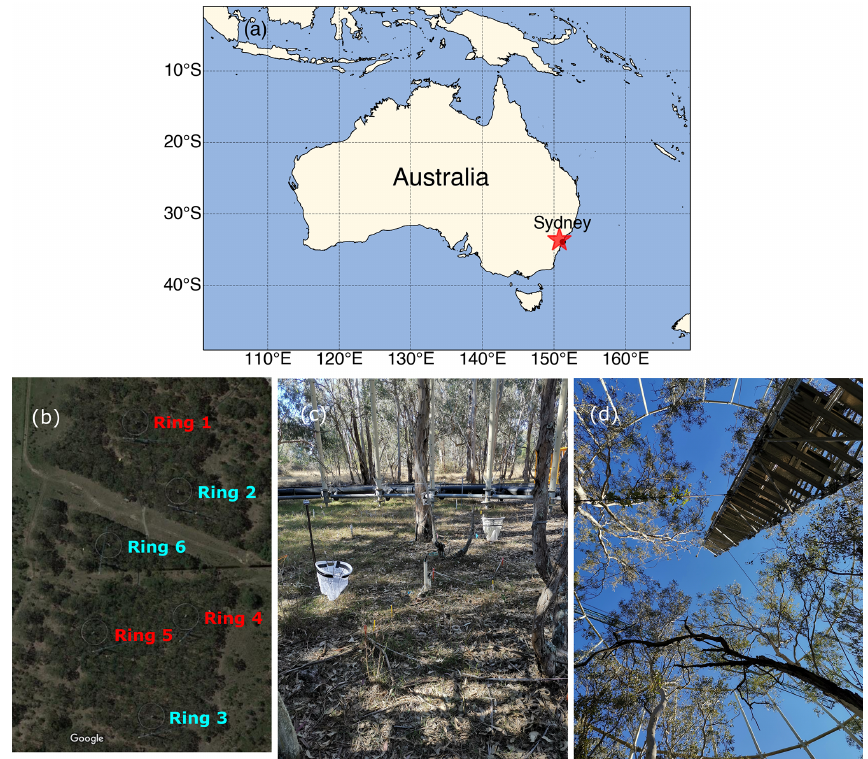
Figure 1. (a) Location of the experimental site in western Sydney, Australia (33 ◦ 36 (cid:48) 59 (cid:48)(cid:48) S, 150 ◦ 44 (cid:48) 17 (cid:48)(cid:48) E) shown by the red star. (b) Dis- tribution of six rings (© Google Maps, 2020, EucFACE experiment site, 1 : 50, available at: https://www.google.com/maps/@-33.6177915, 150.7379194,356m/data=!3m1!1e3, last access: 2 July 2020). (c) Understorey vegetation and infrastructure inside a ring (photograph taken by Mengyuan Mu). (d) Canopy structure and central tower (photograph taken by Mengyuan